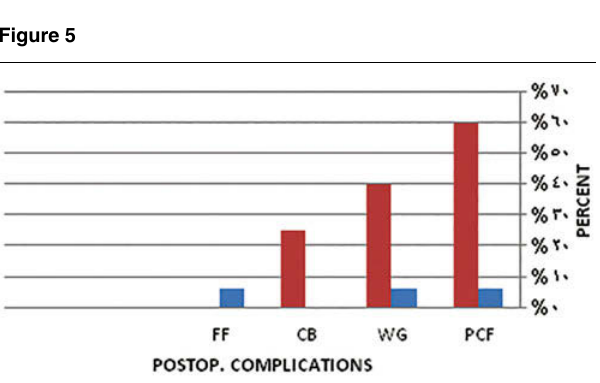
Postoperative complication. Group A: blue, group B: red, pharyngocutaneous (cid:383) stula (PCF), wound gap (WG), carotid